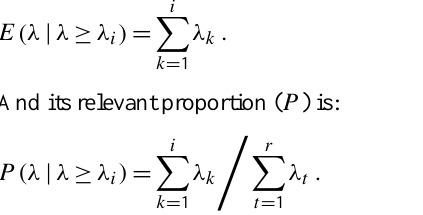
Fig. 3. log-log plot of λ − P with two break points, ln (λ p ) = 17 . 13, ln (λ q ) = 14 .